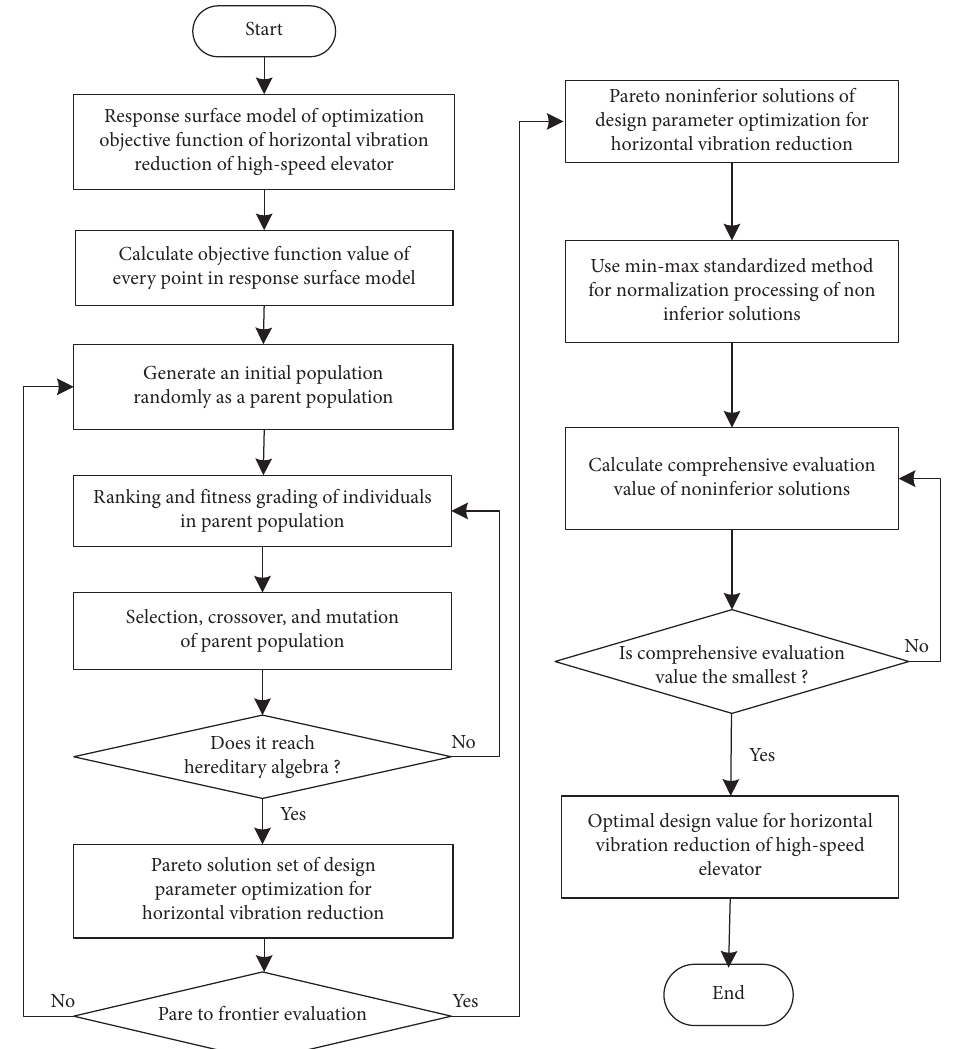
Figure 10: Process chart to obtain an optimal solution of the design parameters for HsEHV reduction based on the MOGA.